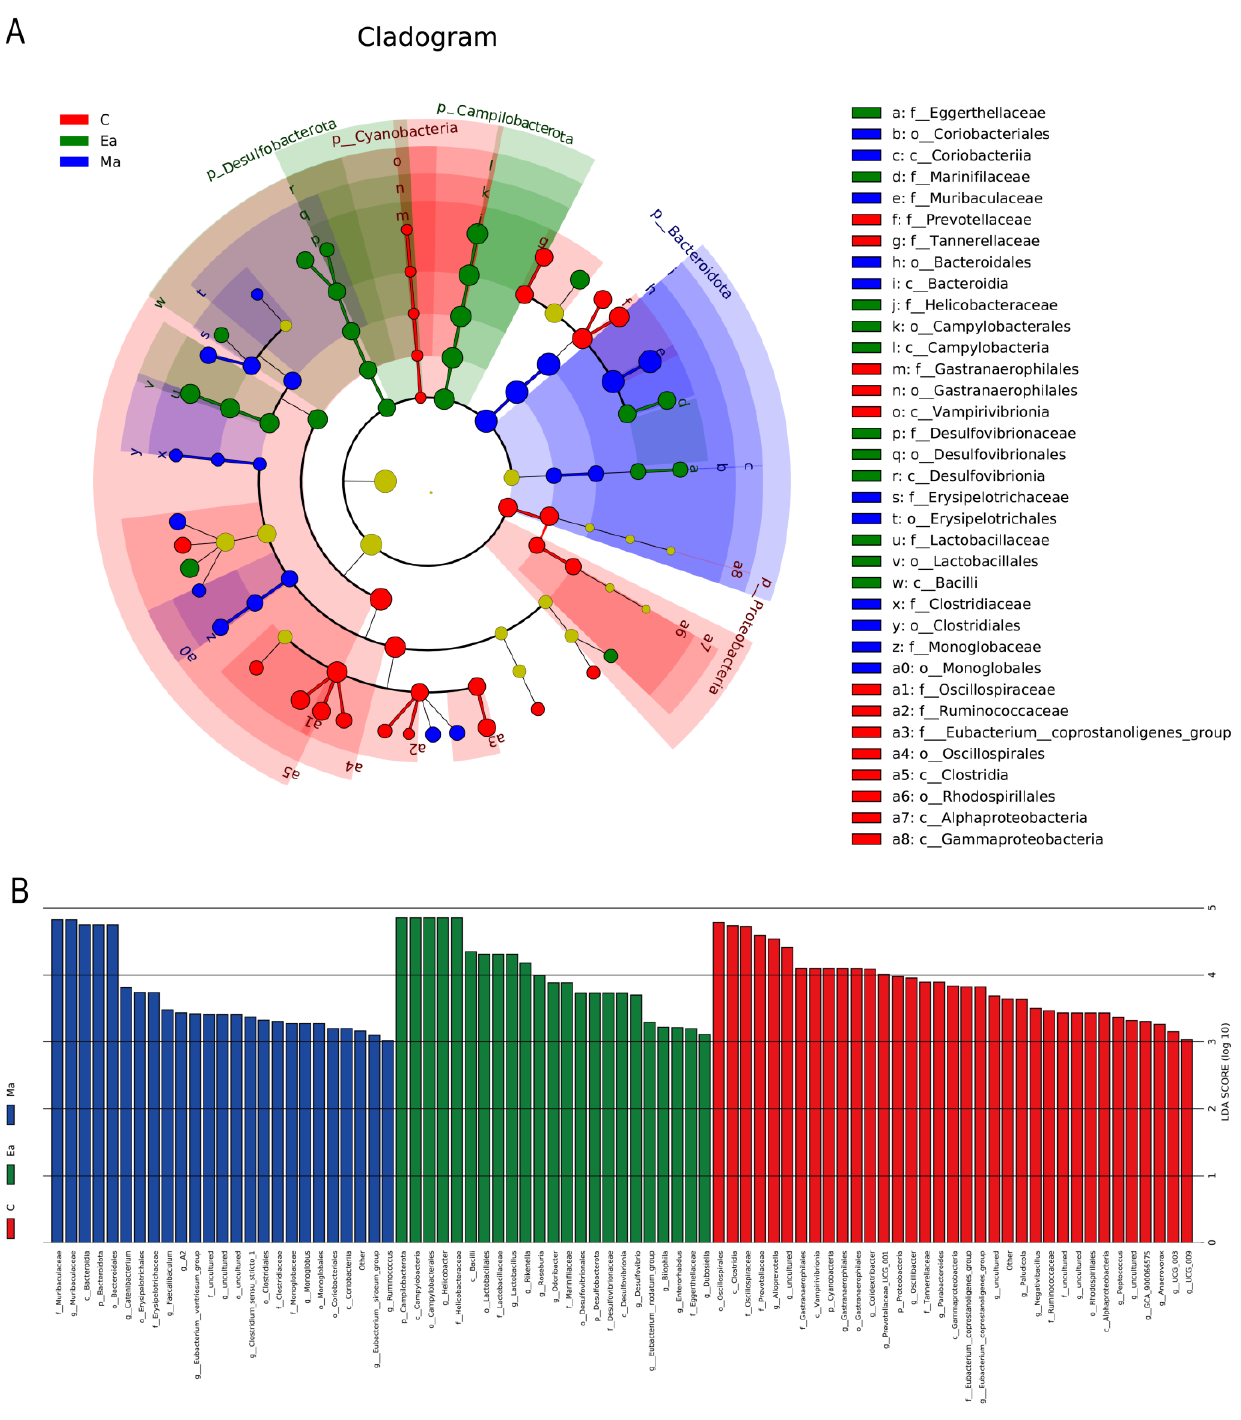
Figure 3. Dominant bacteria taxa in the different groups were identified using LEfSe. ( A ) Annotated branching diagram of differential microbiota; ( B ) Differential microbiota score diagram of differential species. A total of 74 microbial groups with statistically significant and biologically consistent differences were identified. The microbial groups with the greatest differences in the three groups include Bacteroidota and Proteobacteria. In ( A , B ): “red” indicates group C, “blue” indicates group Ma, and “green” indicates group